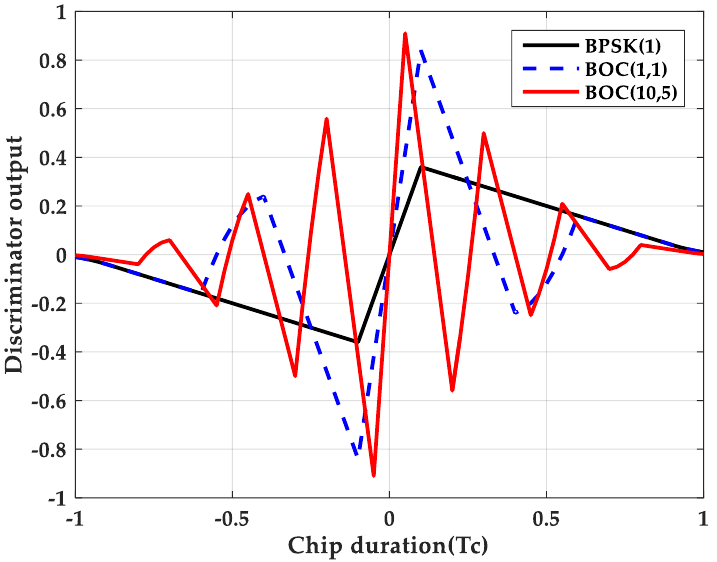
Figure 3. The false acquisition probability of three different factors.